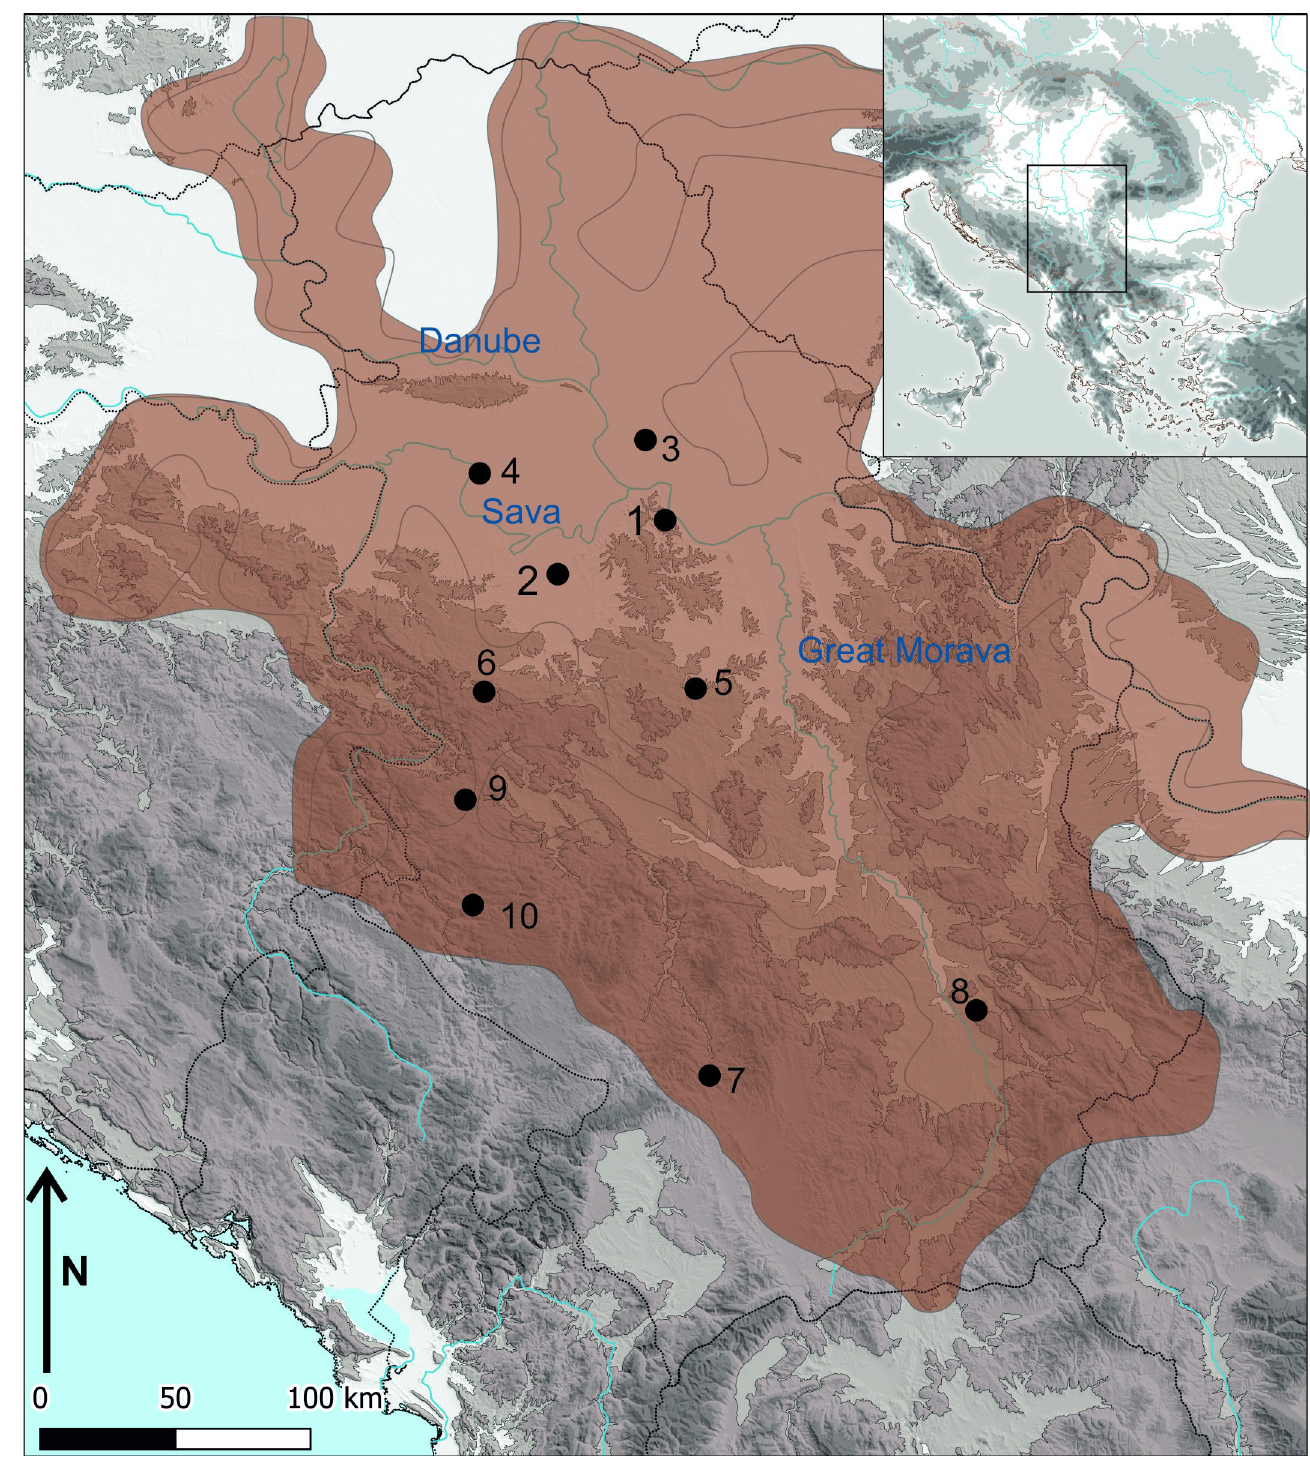
Fig 1. Map of the study sites with Vin č a distribution and sites mentioned in the text. 1. Vin č a-Belo brdo; 2. Stubline; 3. Opovo; 4. Gomolava; 5. Divostin; 6. Petnica; 7. Vala č ; 8. Gradac; 9. Gradina-Stapari; 10. Pljosna Stijena. The base map is available under the CC4.0 at the U . S . Geological Survey . (Credit: Penezi ć / Pendi ć